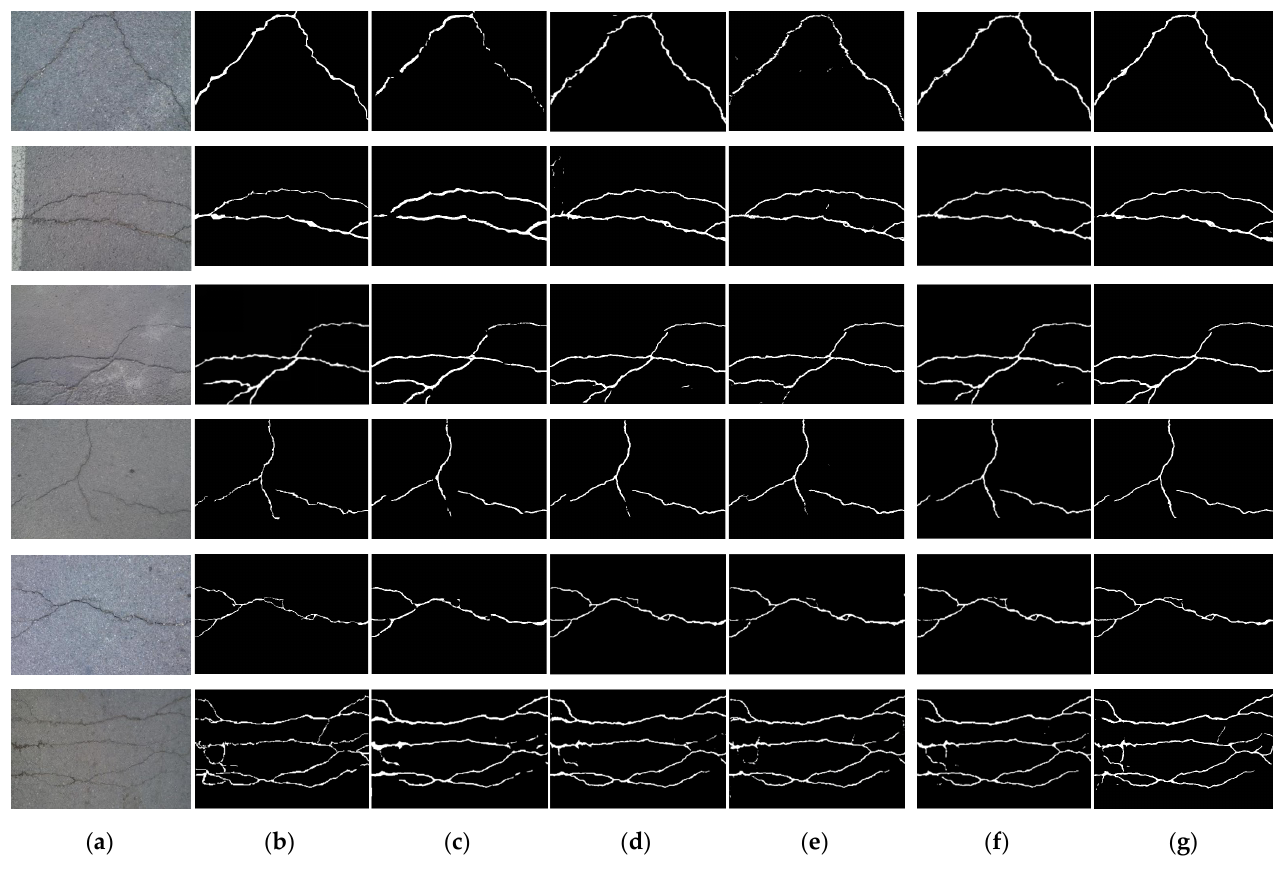
Figure 3. Comparison of predicted results among various methods for the CFD dataset. Columns from left to right: ( a ) original image, ( b ) ground truth, ( c ) FCN, ( d ) Unet, ( e ) SegNet, ( f ) TransUnet, and ( g ) our method. Table 2. The Pr, Re, F1, and IoU of the compared methods for the CFD dataset. Methods